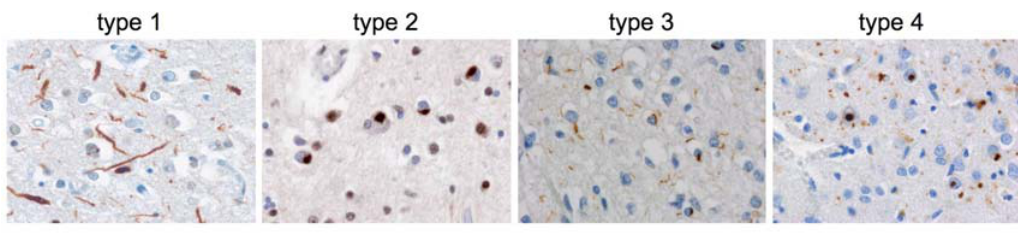
Figure 2. Distinct histological subtypes of TDP-43-positive FTLD-U (“FTLD-TDP”).